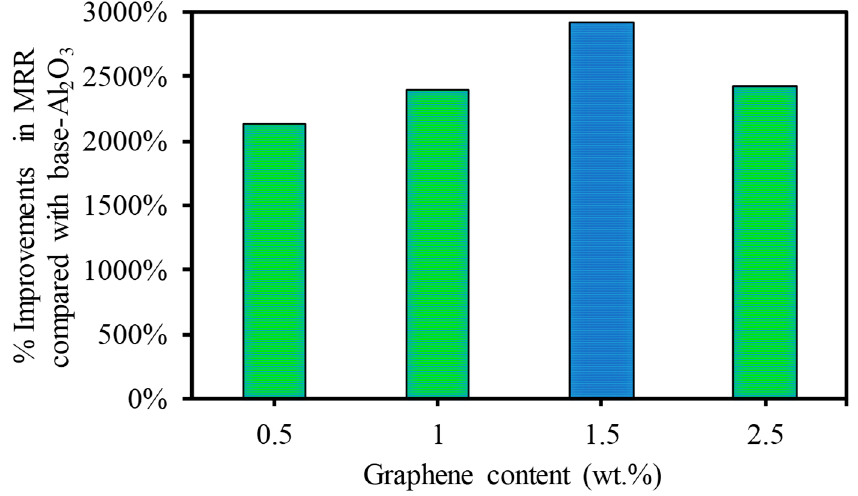
Figure 21. Percentages of improvement in MRR at a higher scanning speed of 500 mm/s.